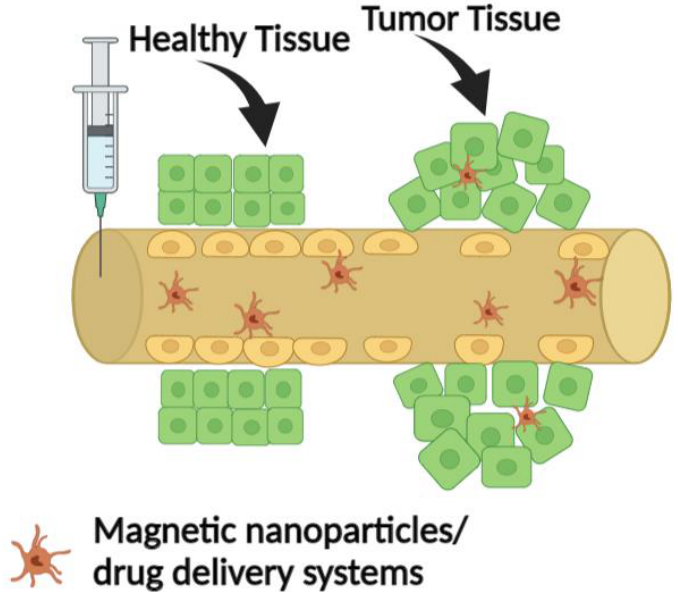
Figure 3. Passive targeting of tumour tissue occurs in blood vessel construction.